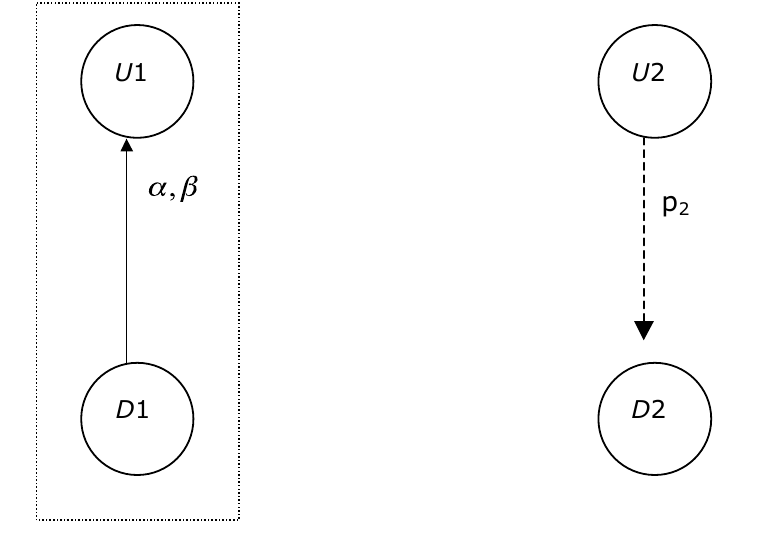
Figure 3. “Competition under asymmetric incentive contract structure”.